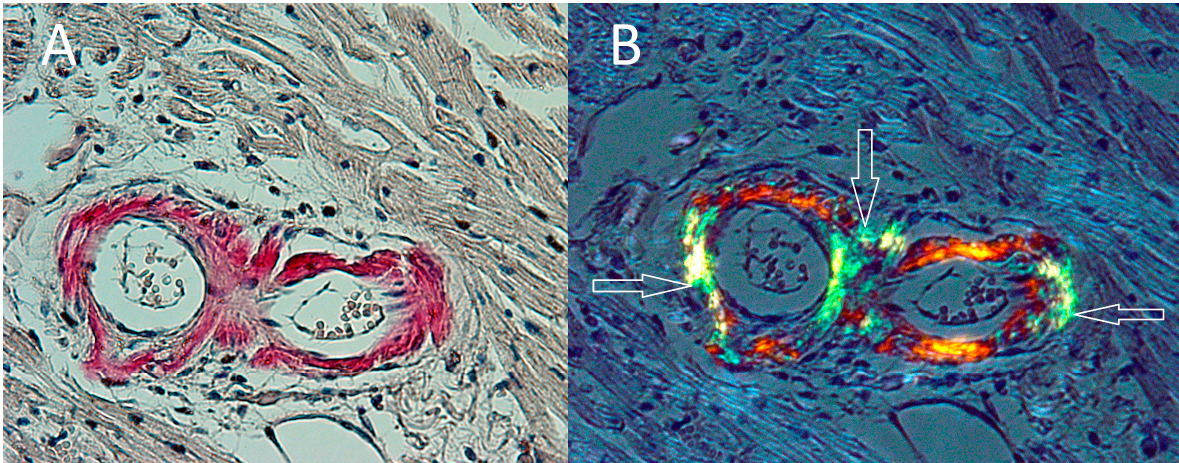
Figure 2. ( A ) Amyloid deposits in the small myocardial arteries. Magnification × 200. Congo red stain. ( B ) The same deposits in the arterial wall under polarized light (white arrows). Magnification × 200. Congo red stain.